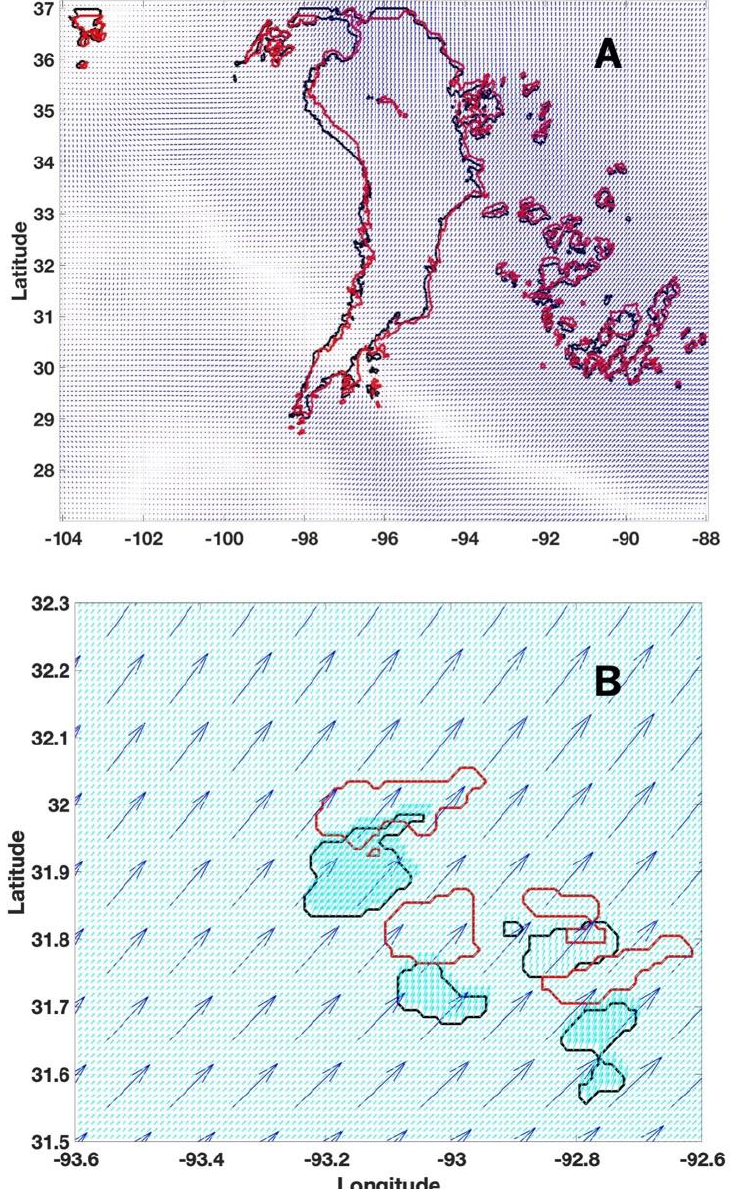
Figure 6. ( A ) The model wind field in the domain with a latitude of 27 ◦ to 37 ◦ and a longitude of − 104 ◦ to − 88 ◦ . ( B ) The model wind field in a zoomed-in region centered at (31.9 ◦ , − 93.1 ◦ ). The original (10 km by 10 km) and interpolated (1 km by 1 km) wind fields are shown with blue and cyan color, respectively. The model data are from 2200 UTC, 25 May 2015.